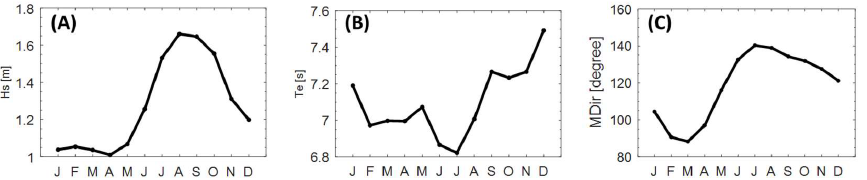
Figure 9. The seasonal variability in Kilifi: ( A ) for H s ; ( B ) for T e ; and ( C ) for MD ir . T e ( B ) has a rather different pattern with three-modal seasonal variability compared with a unimodal pattern observed in both H s ( A ) and MD ir ( C ) respectively.